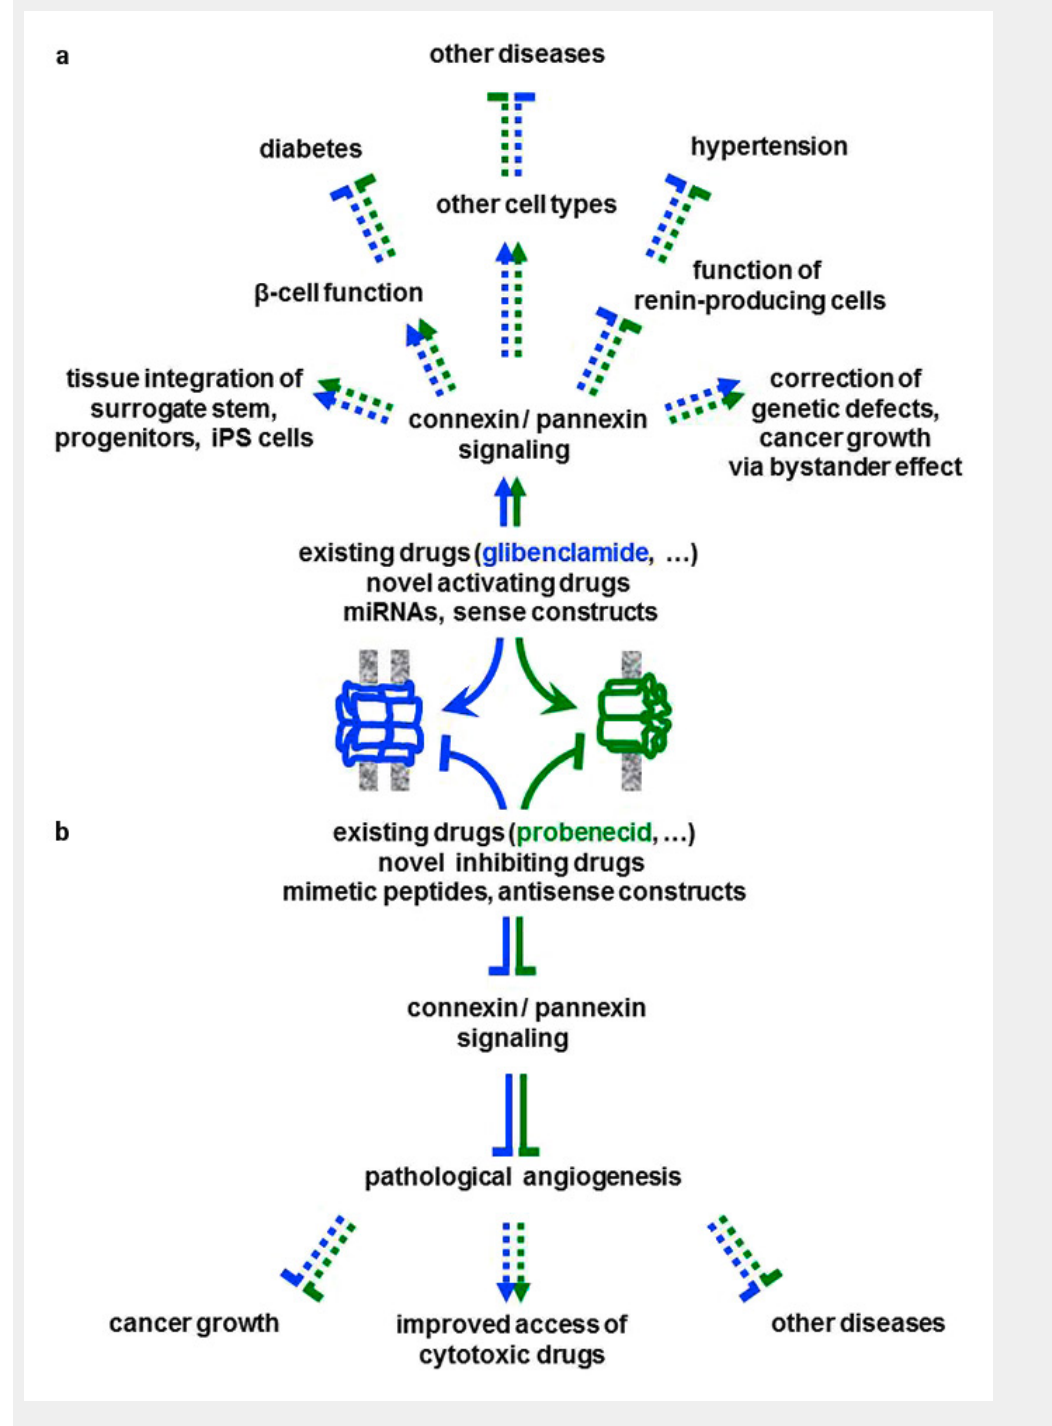
Figure 5 The translational perspectives. (a) The stimulation (arrows) of junctional and non-junctional channels (e.g. those formed by Cx36 and Panx2) is expected (dotted lines) to reproduce in humans the beneficial effects of connexin (blue) and pannexin (green) signalling observed in rodents. In turn, increasing the function of pancreatic β-cells is expected to improve the treatment of type 1 or type 2 diabetes. Increased connexin and pannexin signalling is also expected to foster the integration in the host tissues of surrogate cells designed for cell replacement therapies. (b) Conversely, the inhibition (flat-end lines) of selected connexin species (e.g. Cx40) is expected to prevent the over-stimulation of the renin- producing cells, thus contributing to mitigate several forms of hypertension. The specific down-regulation of Cx40 is also expected to prevent excessive angiogenesis, while preserving a normal vessel wall and function, thus improving the efficiency of current cytotoxic therapies. This combined approach could reduce the growth of some cancer forms and the development of other diseases due to excessive